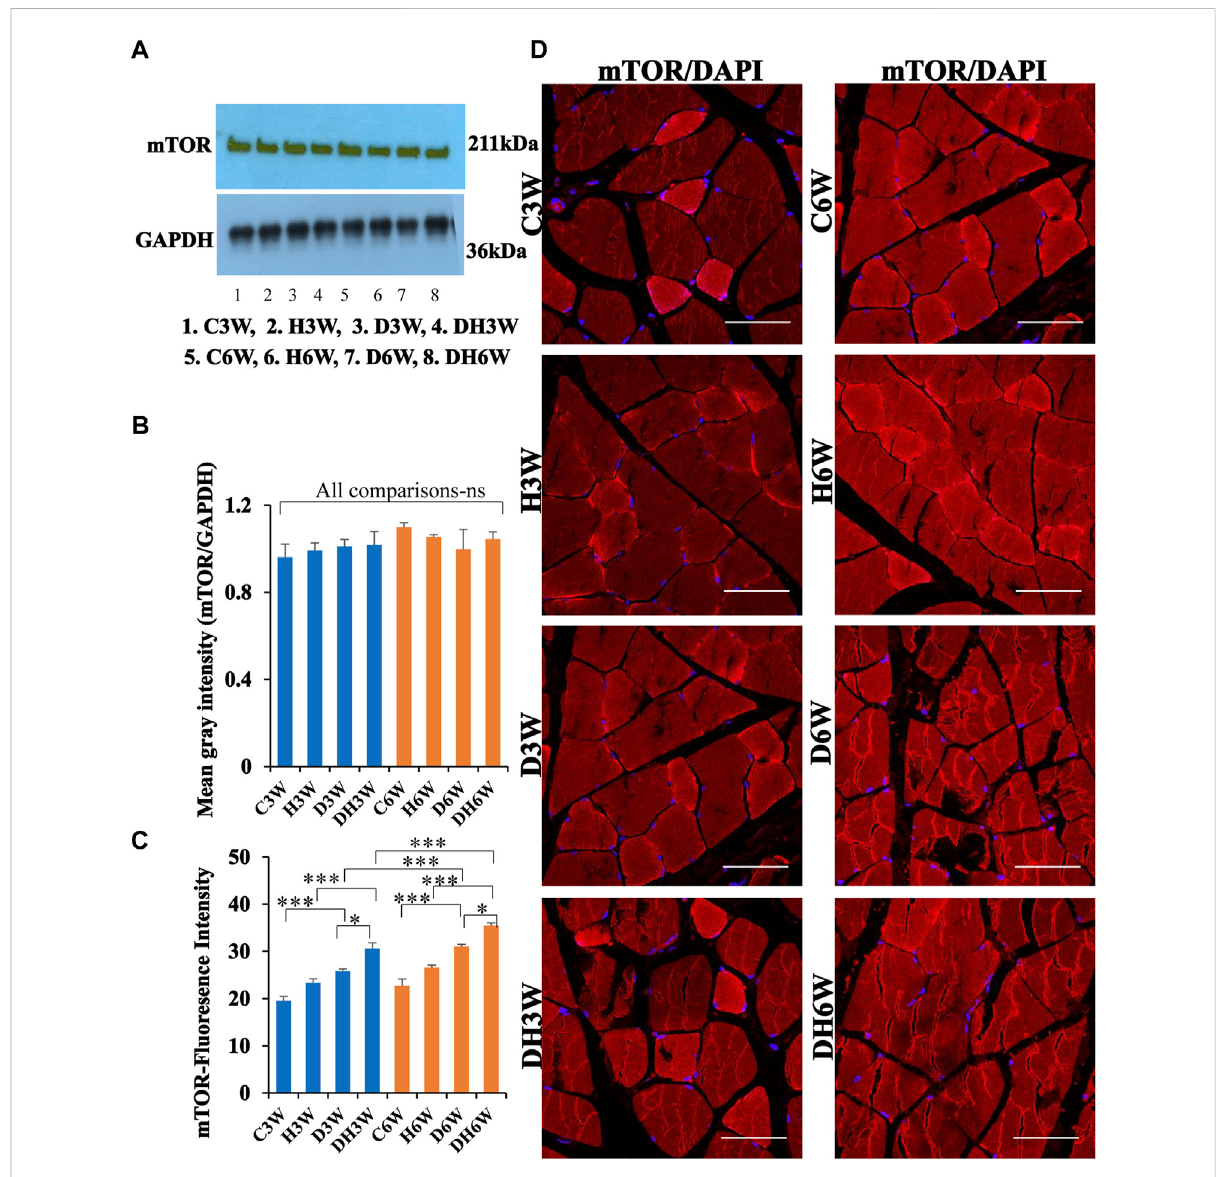
FIGURE 11 (A,B) -Immunoblots probed with anti-mTOR antibody (A) and mean gray intensity of immunoblots. Note there is no signi fi cant difference in expression of mTOR between groups in short- and long-term experiments. Note signi fi cantly increased immuno fl uorescence of mTOR in D3W and D6W compared to C3W and C6W respectively. (C,D) -mTOR immuno fl uorescence intensity (C) and representative cross-section of muscle fi bers stained for anti-mTOR immuno fl uorescence in short-term (left panel) and long-term (right panel) experiments (D) . mTOR fl uorescence was increasedinDH3WandDH6WcomparedtoD3WandD6Wrespectively.Therewasasigni fi cantincreaseinmTORexpressionfromshort-term(D3W and DH3W) to long-term (D6W and DH6W). Note large number of muscle fi bers showing immuno fl uorescence in D3W, DH3W, D6W, and DH6W. (* p < 0.05; ***, p < 0.001, One-way ANOVA, Bonferroni multiple comparison tests, n = 6 in all groups). Scale bar = 50